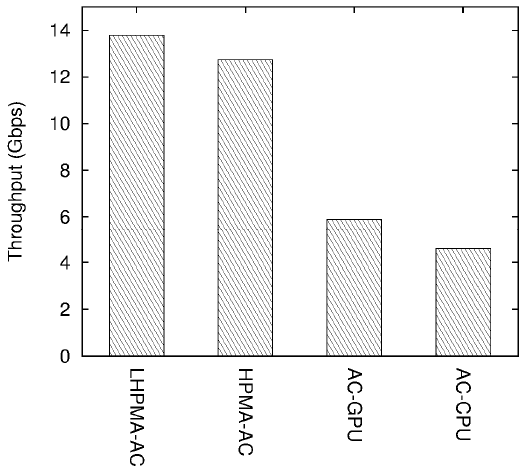
Figure 7. The performance of LHPMA with different payload length boundaries. Algorithms 2017 , 10 , 16